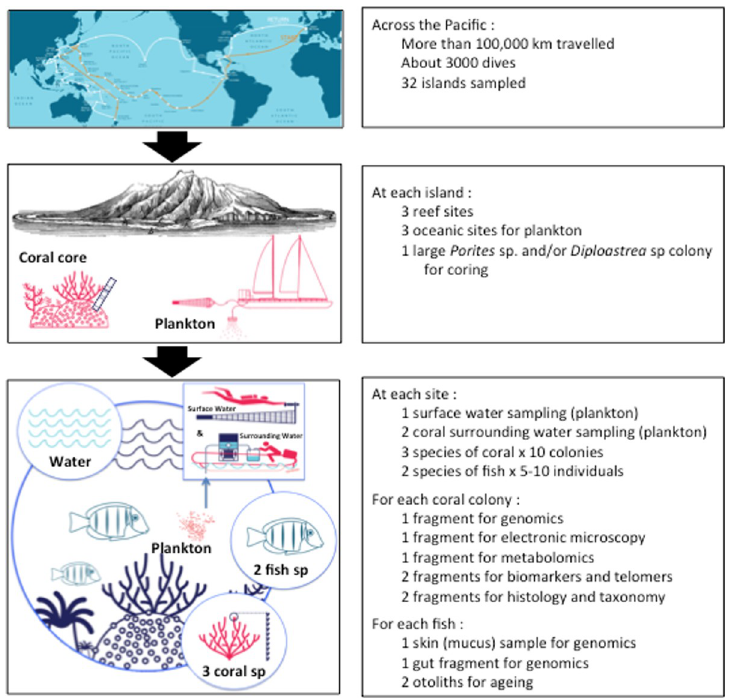
Fig 3. Schematic representation of the sampling design allowing the comparison of various components of coral reef ecosystems. Using the developed protocol, we collected 2,500 oceanic samples (32 islands × 3 oceanic sites × 5 size fractions × 2–5 protocols), 7,500 coral-surrounding and surface water samples (32 islands × 3 coral sites × 3 environments × 5 size fractions × 2–5 protocols), 40 coral core samples (32 islands × 1 Porites sp. and/or Diploastrea sp × 1–2 core samples), 20,160 coral fragments (32 islands × 3 coral sites × 3 species of corals × 10 colonies × 7 protocols), and 9,600 fish tissue samples (32 islands × 3 coral sites × 2 species of fish × 5–10 individuals × 5 protocols). Taken together, the dataset comprises a total of approximately 40,000 samples. Bottom figure copyright to Agence DATCHA/ taraexpeditions.org .